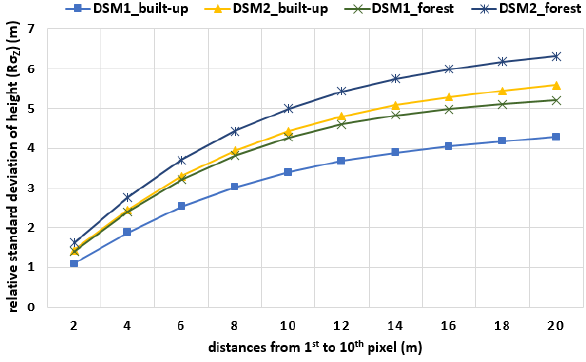
Figure 7. RVAs of generated